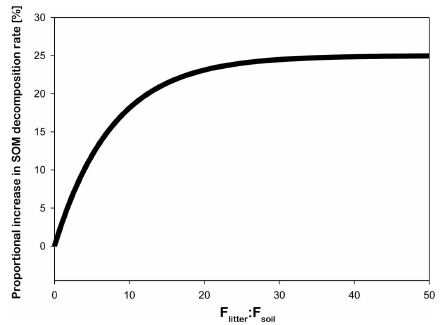
Figure 2. Plot of the proportional increase in decomposition rate of all soil pools, given as percentages, due to priming from an influx of C from the litter pools, computed from Eq. (5). The changes in rates are plotted as a function of the ratio of the sum of the unmodified potential C loss fluxes from all litter pools, F litter , to the sum of the unmodified potential C loss fluxes from all soil pools, F soil